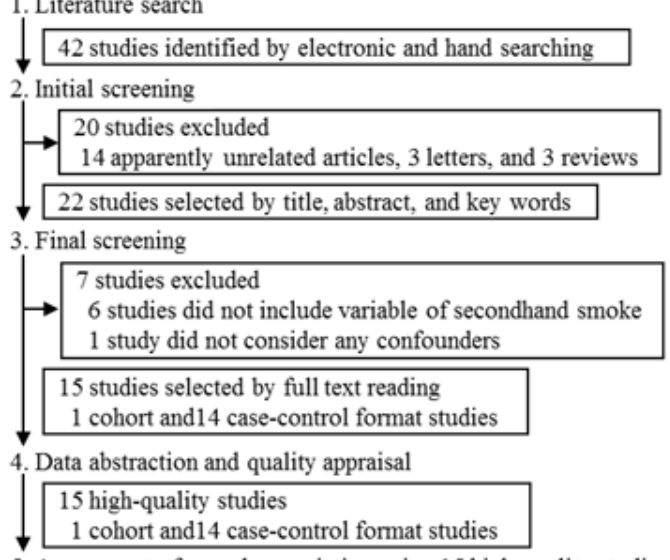
Figure 1. Number of studies according to the processes of searching, selection, and evaluation of